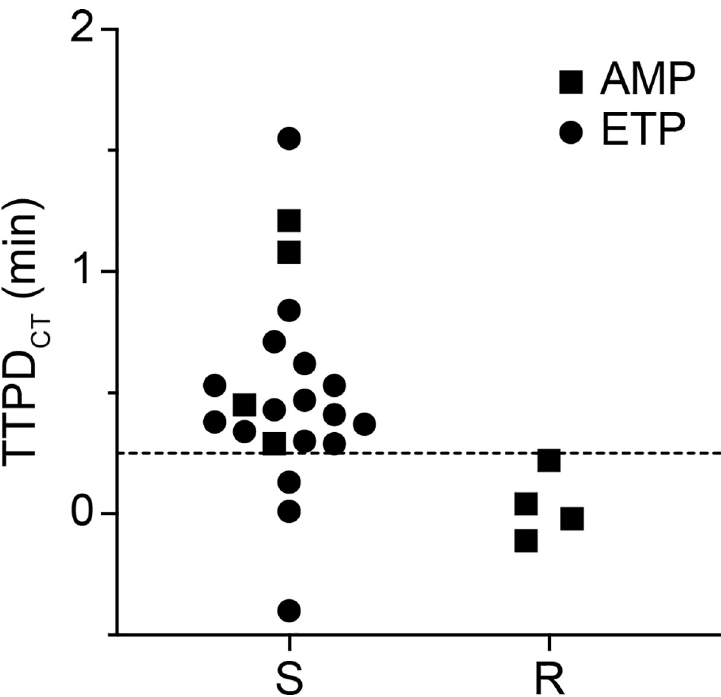
Fig 7. Pilot testing of pol-aAST with clinical UTI samples with a modified protocol (see Methods and Discussion). TTPD CT values for AMP and ETP susceptibility obtained by pol-aAST, with clinical UTI samples containing E . coli . Each point represents the TTPD CT value for one clinical sample tested once by pol-aAST (S2 and S4 Tables). LAMP was performed in technical triplicate, see S4 Table for values and statistical details. AMP, ampicillin; AST, antibiotic susceptibility testing; ETP, ertapenem; LAMP, loop-mediated isothermal amplification; pol-aAST, polymerase- accessibility AST; R, resistant; S, susceptible; TTPD, time-to-positive difference; TTPD CT , TTPD control to treated; UTI, urinary tract infection.